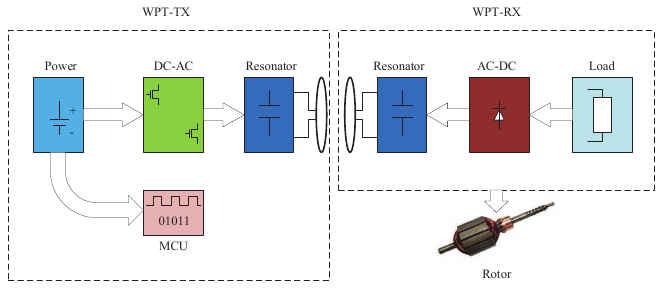
Figure 1. Wireless power transfer (WPT) system composition. AC: alternating current; DC: direct current; MCU: microprogrammed control unit; WPT-TX: transmitting unit of WPT; WPT-RX: receiving unit of